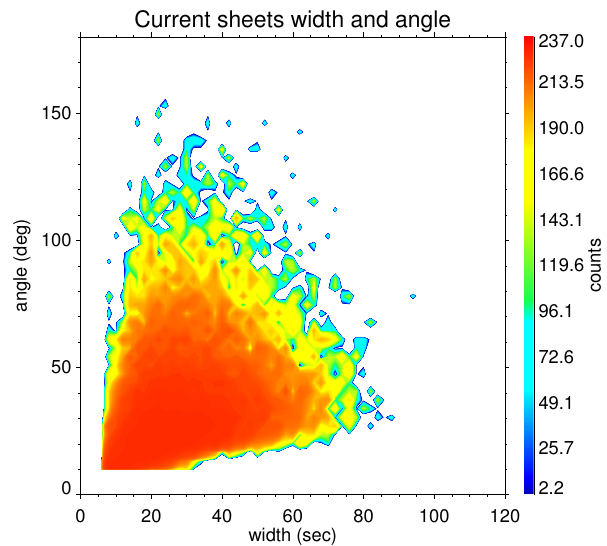
Fig. 6. Angle between the magnetic field of adjacent flux tube. The red dashed line is the fitting curve by using exponential function ◦ A 1 e − 1θ/ 30 . 01 , A 1 is a constant. The blue dashed line is the fit- ting curve by using exponential function A 2 e − 1θ/ 18 . 58 constant.